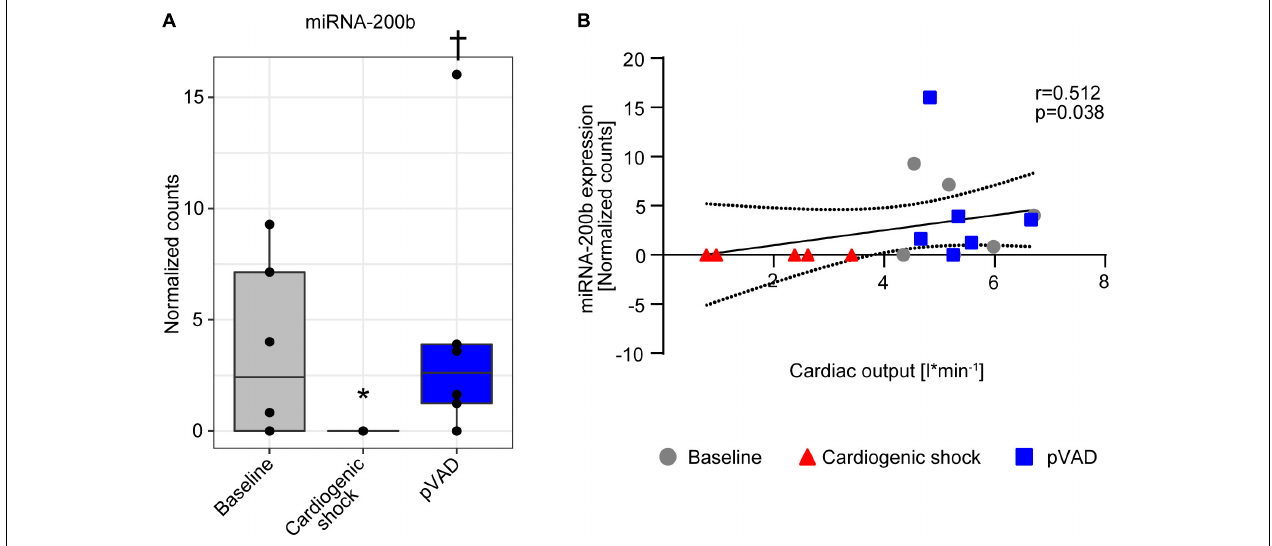
FIGURE 4 | miRNA-200b expression in serum. (A) miRNA-200b expression at time points as indicated. Data are presented as median ± interquartile range (IQR), n = 5–6. * p < 0.05 vs. Baseline; † p < 0.05 vs. Cardiogenic shock; pVAD, percutaneous ventricular assist device. (B) Spearman correlation with 95% confidence intervals calculated by linear regression model between miRNA-200b expression and cardiac